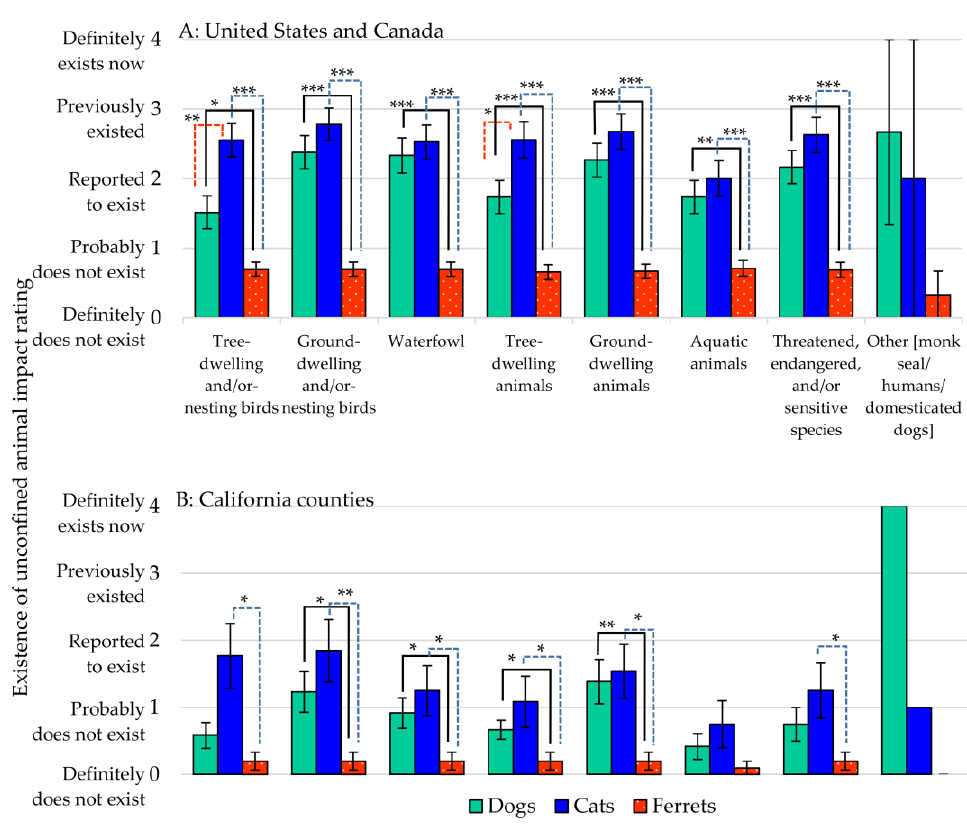
Figure 4. “Existence” of incidents (impact) on wildlife in parks and recreational areas from unconfined dogs, cats, ferrets ( A ) United States, Canada, and ( B ) California counties. Rating mean ± standard error of the mean (sem). Asterisk represents significant difference; * p < 0.05, ** p < 0.01, and *** p < 0.001.